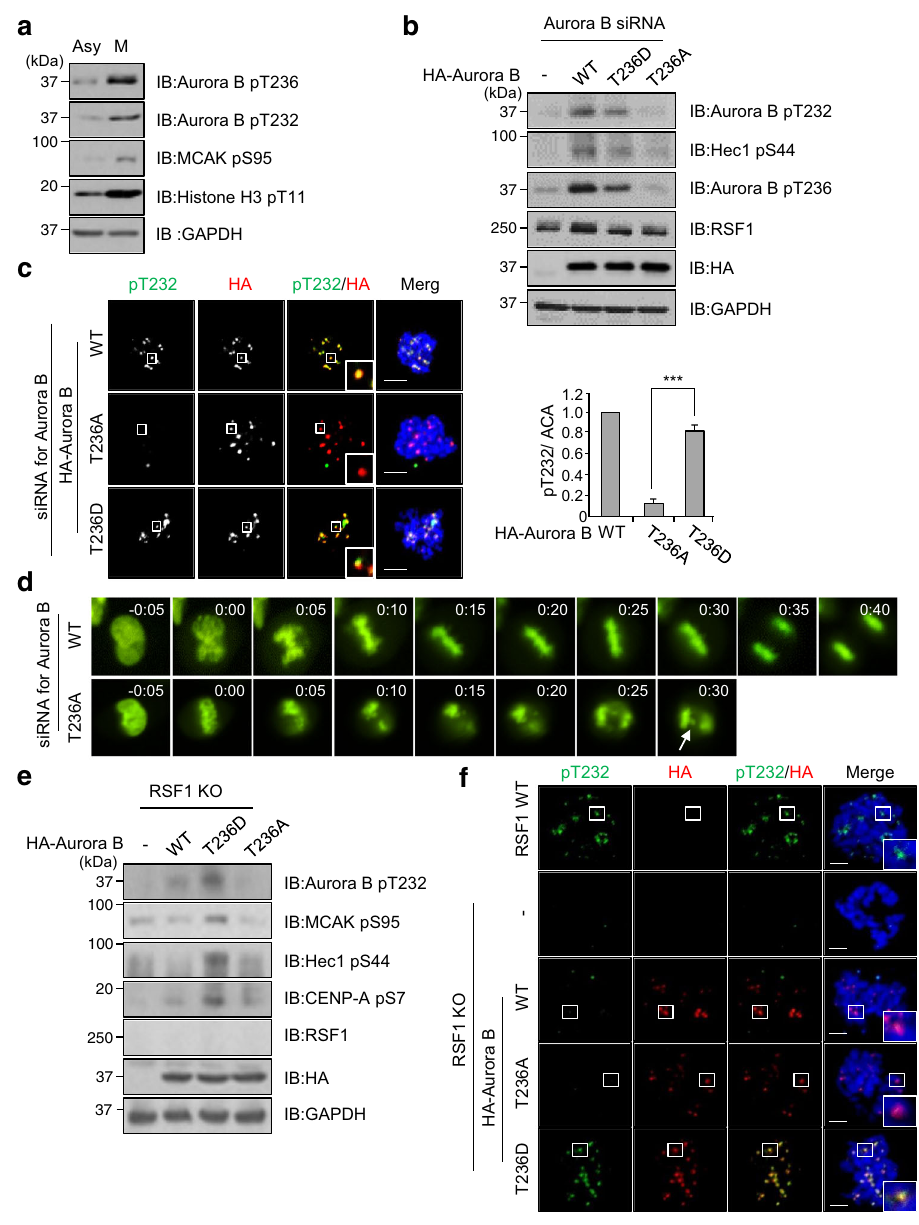
Fig. 4 Perturbation of Aurora B phosphorylation on Thr236 causes defects in chromosome segregation. a Asynchronously growing HeLa and nocodazole-treated HeLa cells were analyzed by immunoblotting with the indicated antibodies. b Immunoblotting of mitotic cell lysates in Aurora B depletion cells after reintroduction of HA-Aurora B WT or T236A/D mutants. c Aurora B-depleted HeLa cells were co-transfected with HA-Aurora B WT or T236A/D mutant. Floating mitotic cells were obtained after nocodazole treatment for 4 h and subjected to immuno fl uorescence images. Images were obtained from representative mitotic cells: pT232-Aurora B (green), HA (red), and DAPI (blue). Statistical analysis of pThr232-Aurora B immuno fl uorescence intensity at the centromeres. Bars represent mean ± SEM from three independent experiments; WT n = 32, T236A n = 46, T236D n = 39 cells. *** p < 0.001 by two-sided unpaired Student ’ s t -test. Scale bar, 5 μ m. d H2B-GFP and Aurora B constructs (WT, T236A) were co-transfected in endogenous Aurora B-depleted cells and synchronized at the G1/S boundary by the double thymidine block (DTB) method. Cells were released from DTB for 8 h and carried out time-lapse imaging analysis for 48 h after DTB release. Images were acquired every 5 min. WT n = 107, T236A n = 180 cells. Scale bar, 5 μ m. e HA-Aurora B WT or T236A/D mutants were transfected in RSF1 KO cells and analyzed by immunoblotting. f Floating mitotic cells were obtained after nocodazole treatment for 4 h and subjected to immuno fl uorescence image: pT232-Aurora B (green), HA (red), and DAPI (blue). Data of a , b , d are representative of three independent experiments. Data of e are representative of two independent experiments. Source data are provided as a Source Data fi